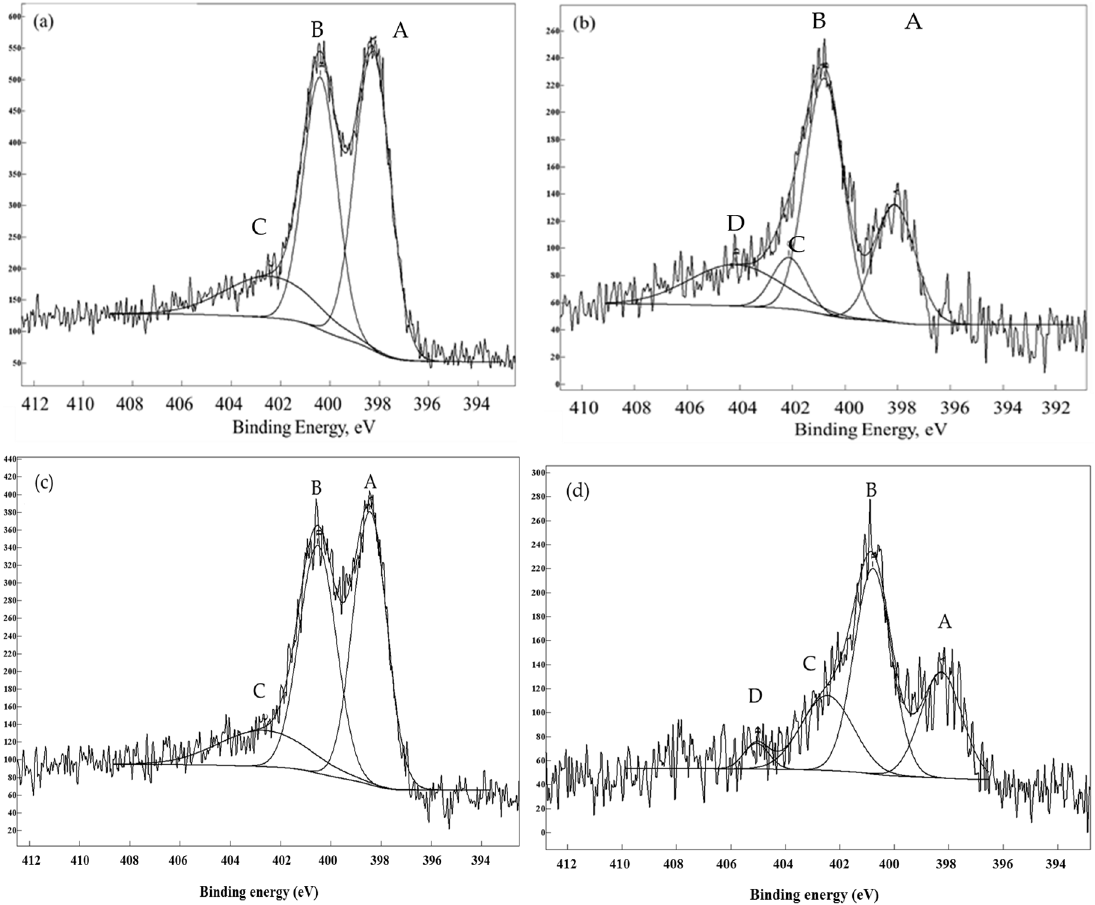
Figure 4. N1s analyses for GaG600 ( a ), GaG900 ( b ), Pd/GaG600 ( c ), and Pd/GaG900 ( d ), showing the presence of pyridinic (A), pyrrolic (B), pyridine oxide (C) and nitro-type nitrogen (D).